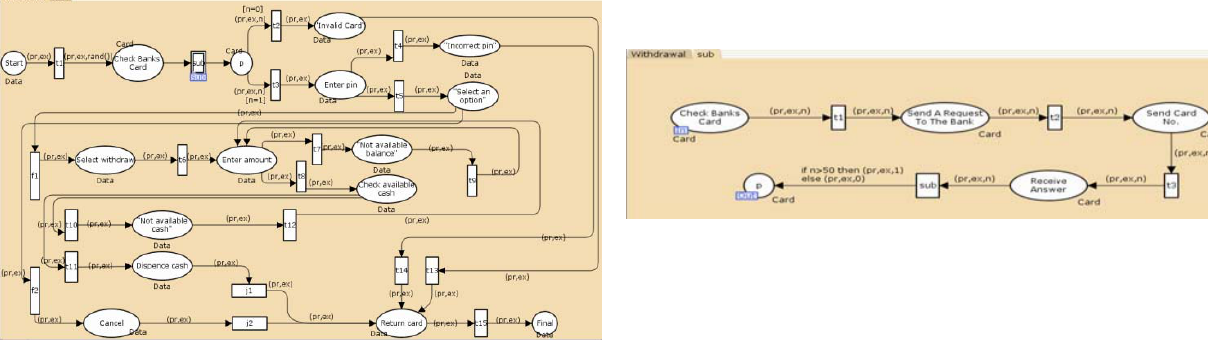
Fig. 12 . Equivalent CPN with withdrawals activity diagram Fig. 13. Page related to sub